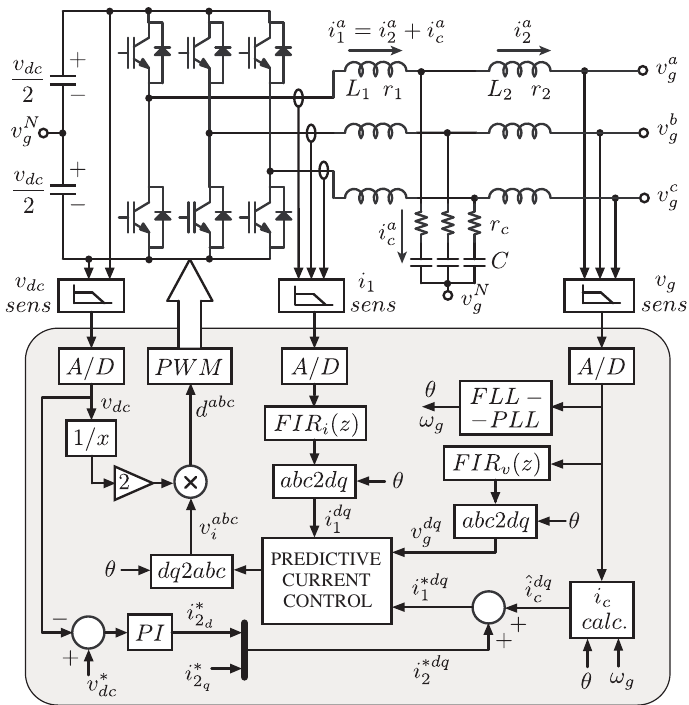
Figure 1. Transformerless three-phase grid-connected inverter with LCL filter, predictive current control and harmonics cancellation